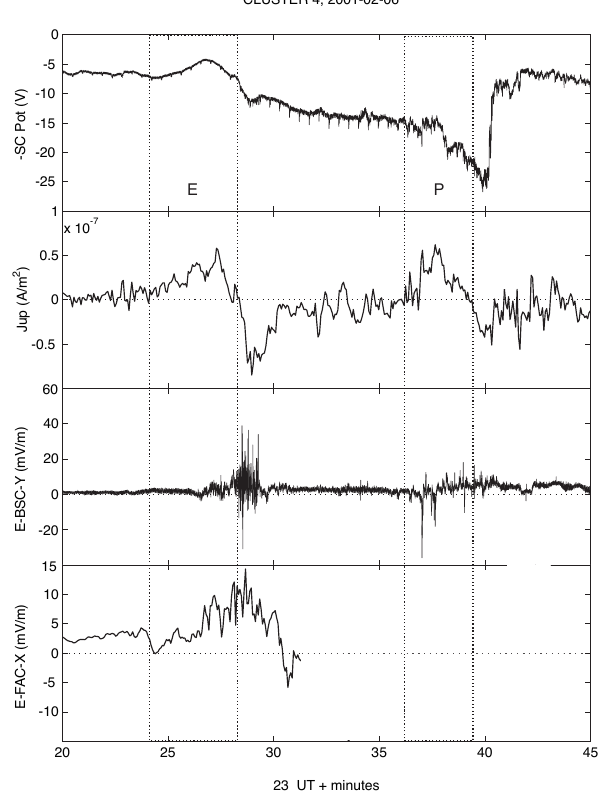
Fig. 7. As Fig. 5, but for